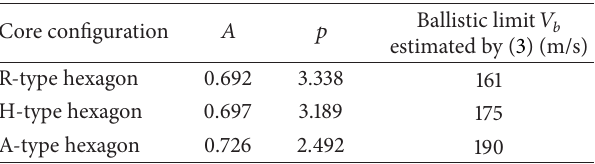
Figure 9: Time history of the transient velocity of the projectile with = 170 m/s. Here 𝑉 𝑉 𝑖 𝑟 is the residual velocity. Table 1: Values of empirical parameters in (3) and ballistic limits for the three types of